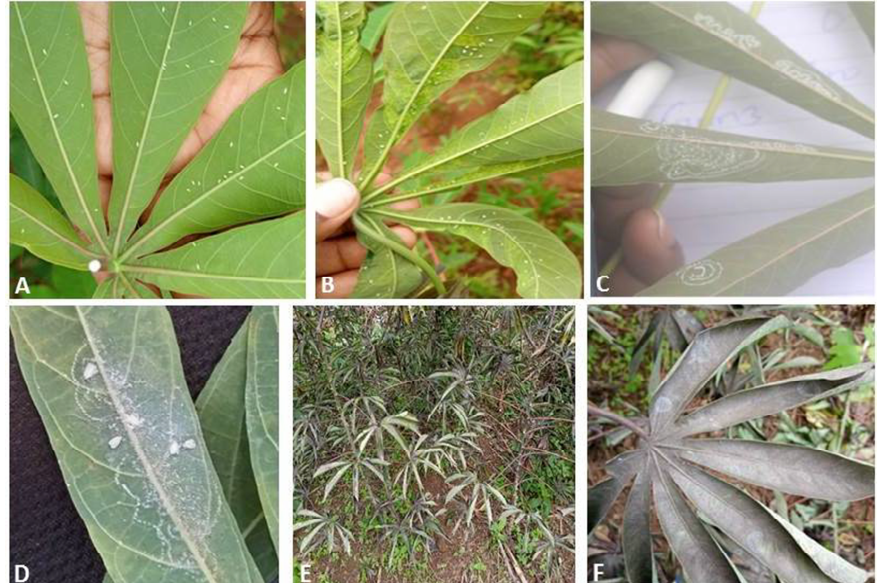
Figure 2. Adult whiteflies on the underside of cassava leaves ( A , B ). Spiraling marks left by spiral- ing whitefly species on the underside of cassava leaves ( C , D ). Characteristic wilting and sooty mold fungus caused by heavy whitefly infestation on cassava plants ( E , F